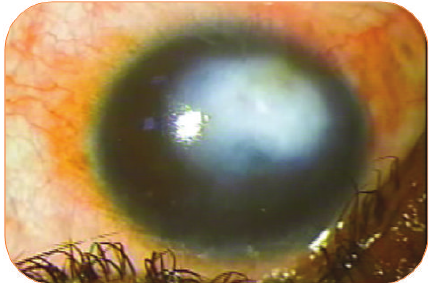
Figure 3: Disappearance of neovascularization after 4 injections in the same